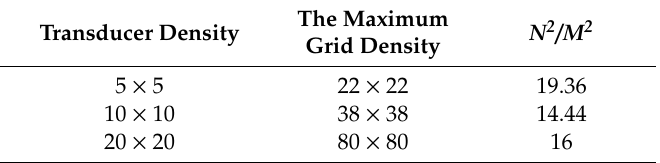
Table 4. The maximum number of grids when given the number of transducers. Transducer